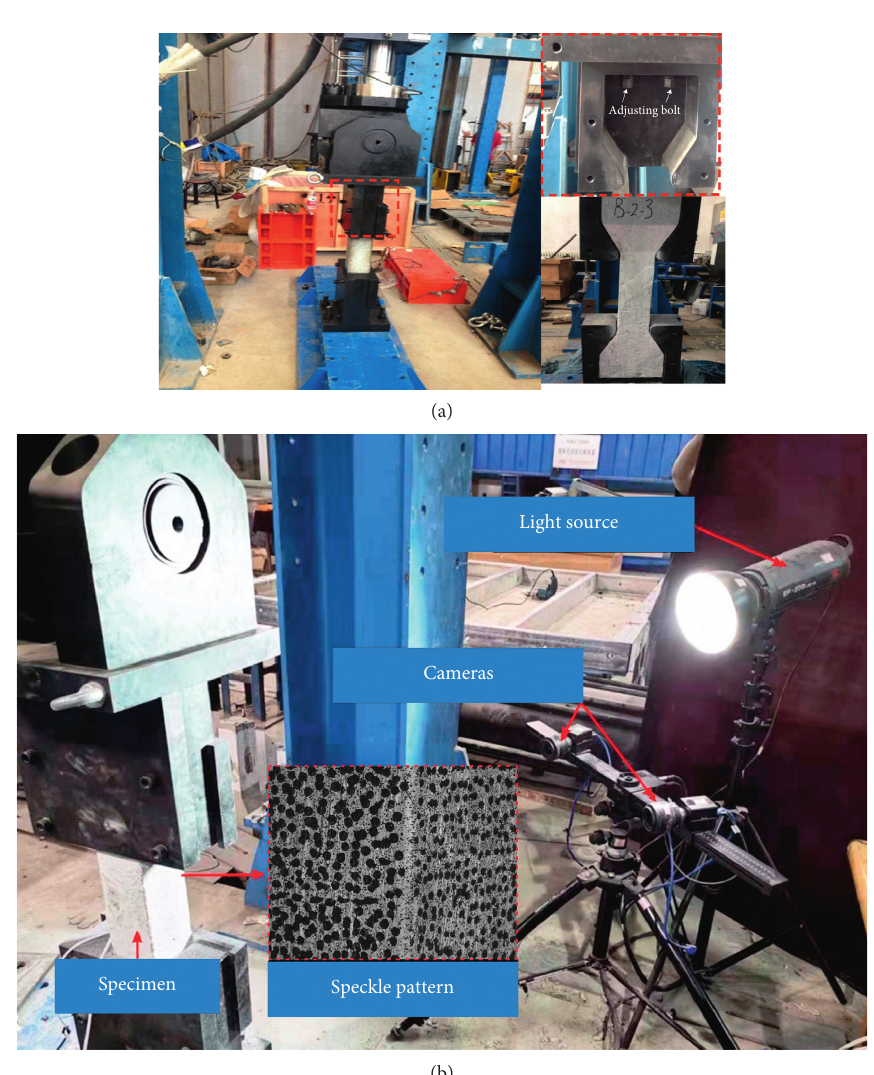
Figure 4: Schematic diagram of test setup. (a) Schematics of the loading instrument. (b) Schematics of the 3D-DIC